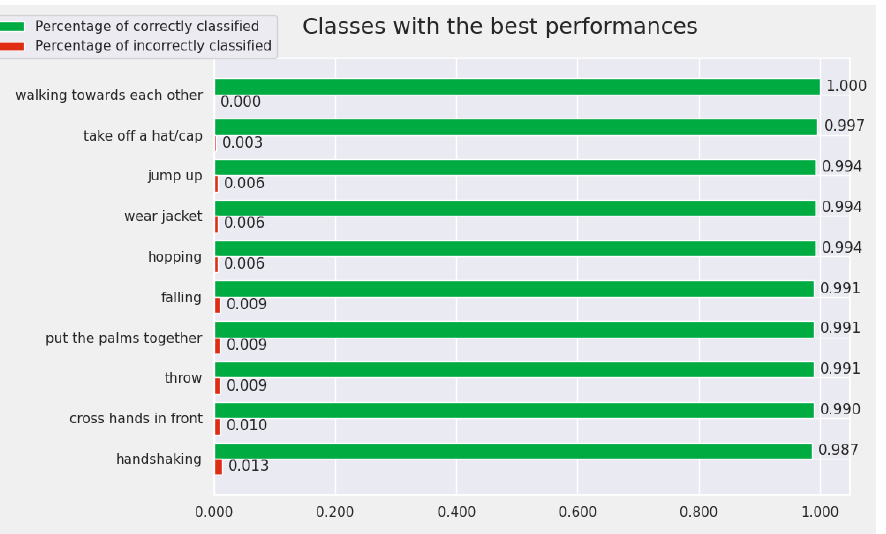
Figure 7. The Top 10 best-recognized classes by the proposed model (from the perspective of Cross- View